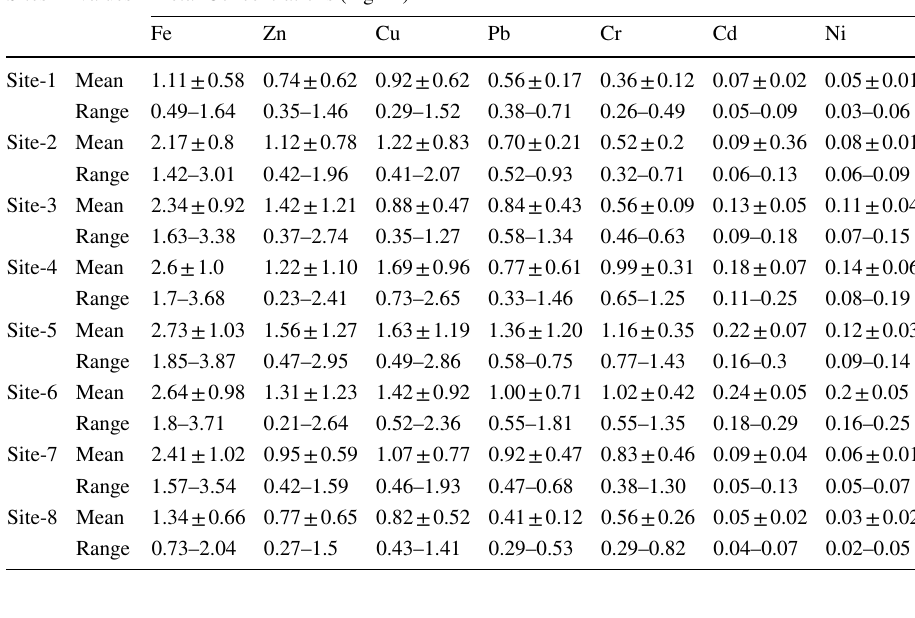
Table 7 Mean concentration of heavy metals during wet